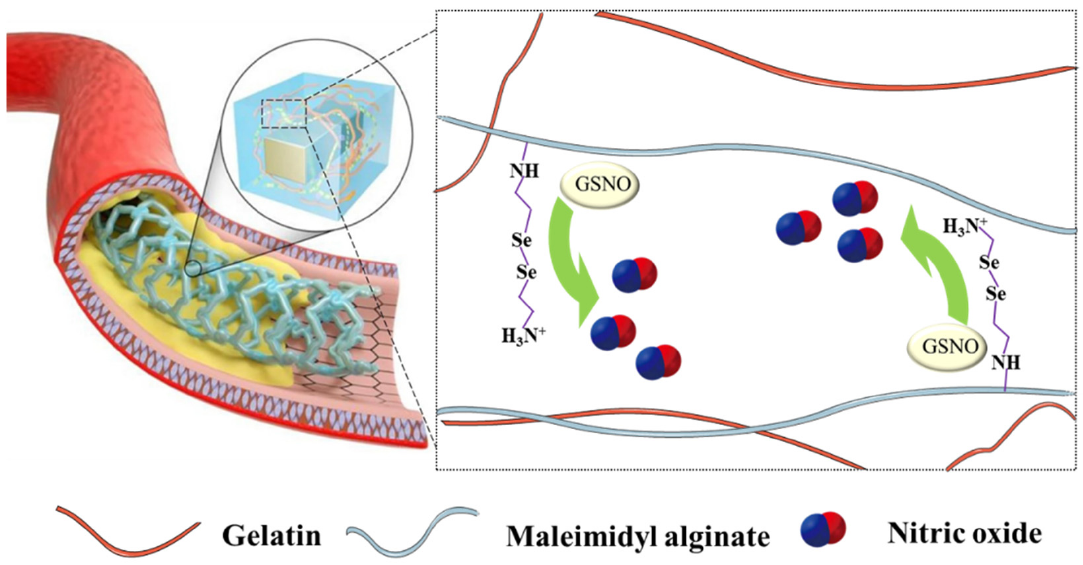
Figure 8. Schematic diagram of NOE hydrogel. Hybrid hydrogels made up of gelatin and maleimide-modified alginate, which are conjugated with SeCA to produce NO by catalyzing endogenous GSNO. The hydrogels could be used as coating for vascular stents. Reproduced with permission from [112], Nature Communications, 2021.